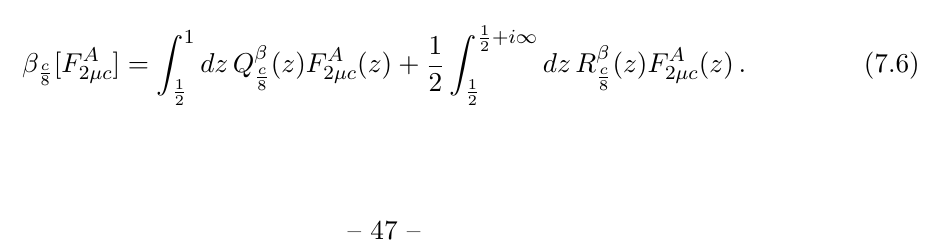
Figure 6 . Action of the functional (cid:12) c curve corresponds to the U(1) c vacuum and the blue one to the Vir c vacuum. The action on both kinds of vacuum characters vanishes at c = 4 and c = 12, where (cid:12) c The plot also illustrates that the vacuum action is positive for c vacuum action increases exponentially with c